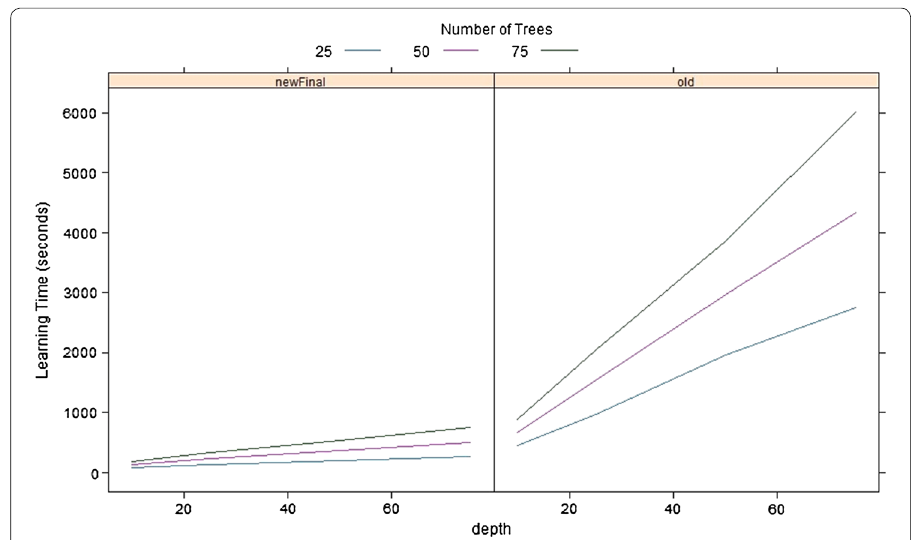
Fig. 11 Final Learning runtime comparison for increasing maximum level of trees